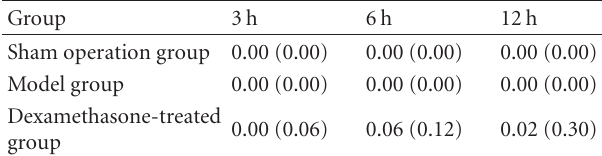
Figure 5: Treated group: 12 hours; Tunel × 200. Table 5: Comparison of apoptosis index of the thymus ( M ( Q R